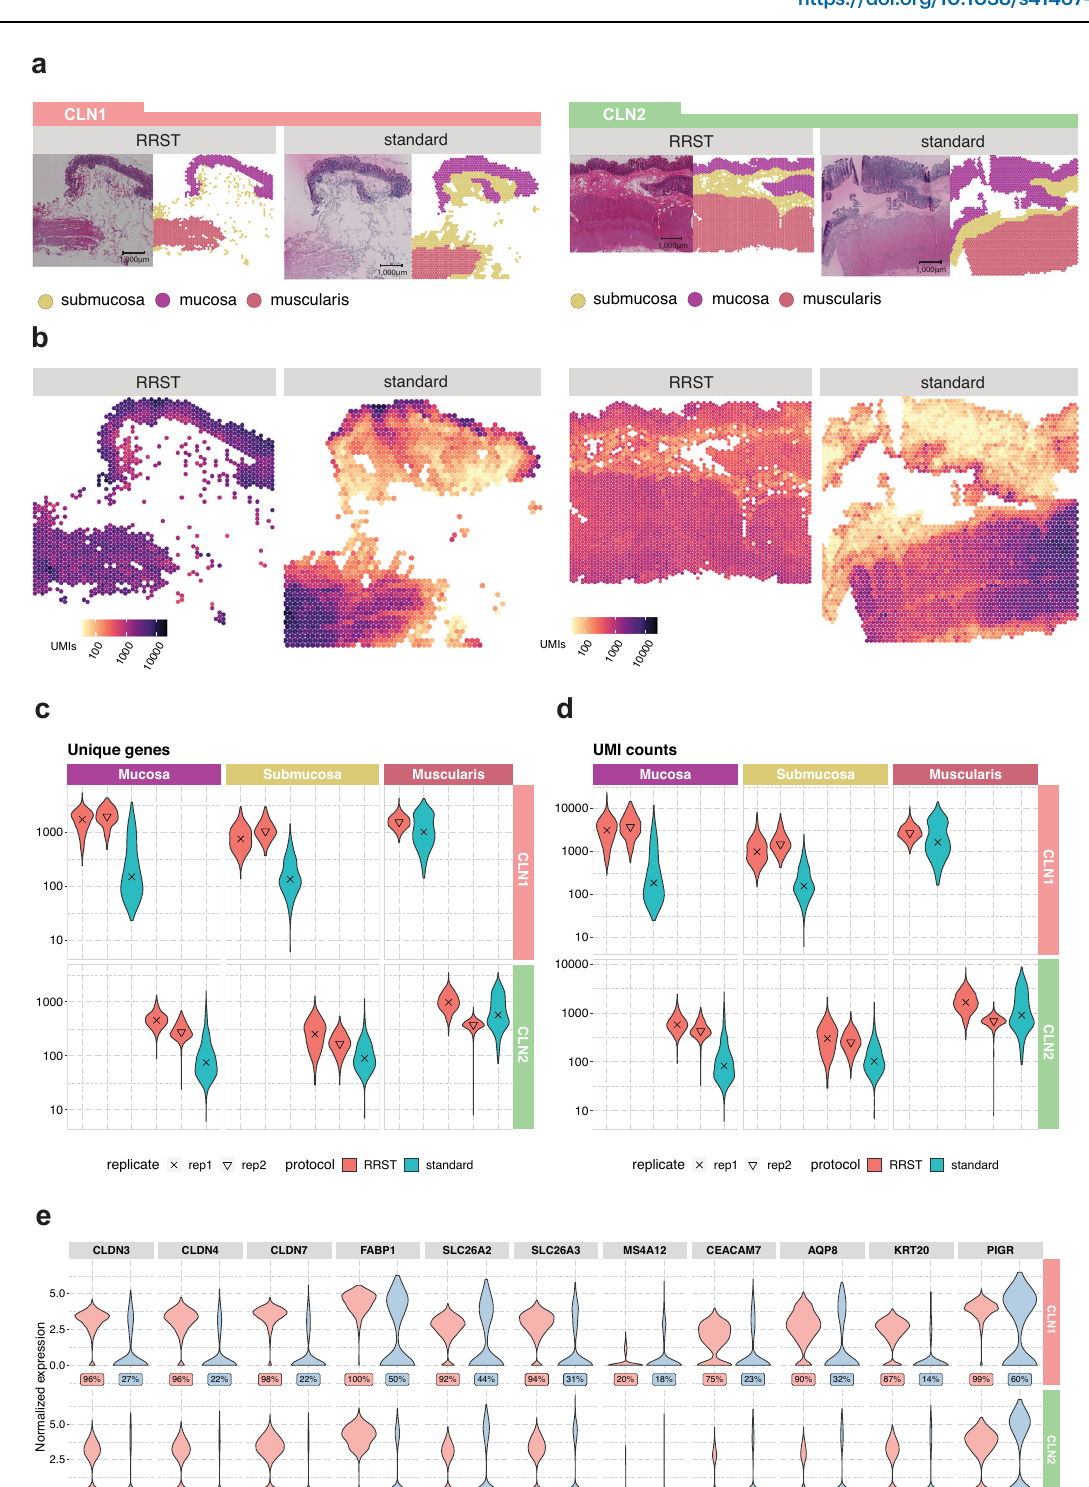
Fig. 3 | Comparison of data quality in RRST and standard Visium datasets generated from adult human colon tissues. a Representative H&E images and annotated regions for two patient samples processed by either RRST ( n =4) or standardVisium( n =2)protocol.Thespotsineachtissuesectionwere labeled into three categories: mucosa, submucosa, and muscularis. b Distribution of UMI counts in the tissue sections shown in ( a ). The color scale represents log10- transformedcounts. c Distributionofuniquegenesperspotinthethreeannotated regions (mucosa, submucosa, and muscularis) visualized as violin plots, for all